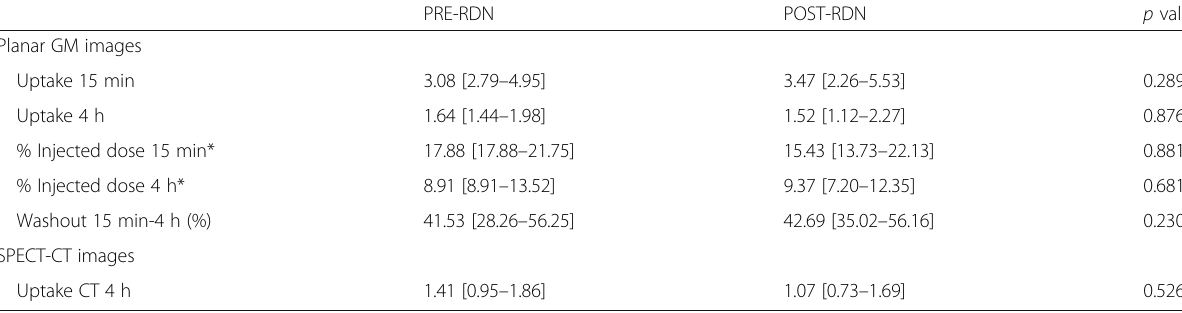
Table 2 Pre and post RDN differences in quantifications of 123 I – m IBG uptake ( n = 21)